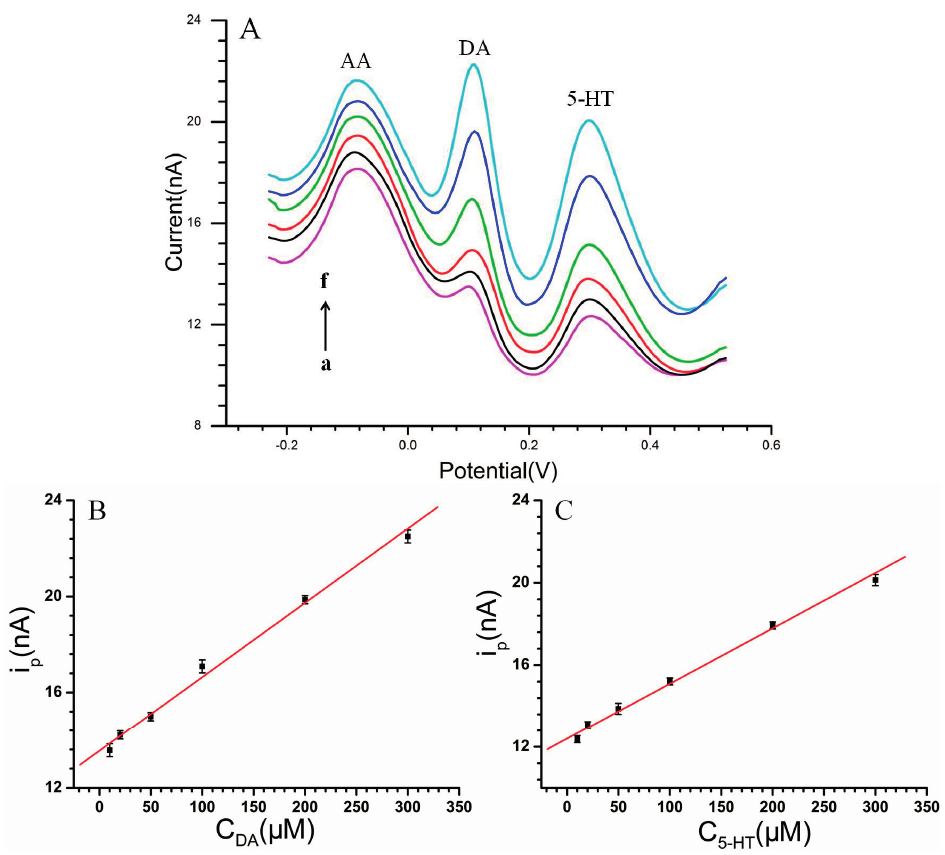
Figure 7. ( A ) DPVs of DA coexisted with 5-HT in the presence of 3 × 10 − 3 M AA, DA and 5-HT concentration (a–f): 1 × 10 − 5 M to 3 × 10 − 4 M; ( B ) The linear relationship between the DA concentration with the oxidation peak current; ( C ) The linear relationship between the 5-HT concentration with the oxidation peak current, respectively. Solution: pH 7.4 phosphate